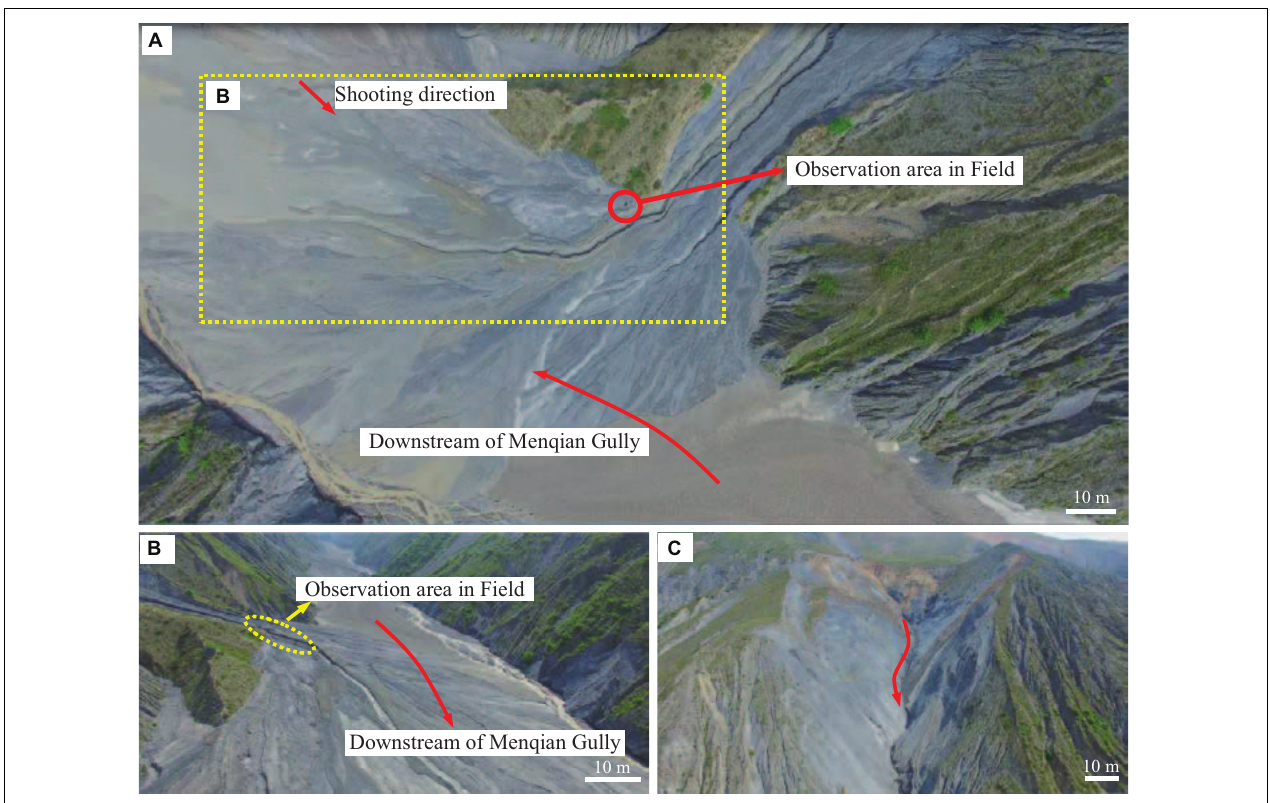
FIGURE 1 | Aerial image of the tributary gully. (A) Top view of the middle and lower tributary gully. (B) Side view of the middle and lower tributary gully. (C) Upstream of the tributary gully.